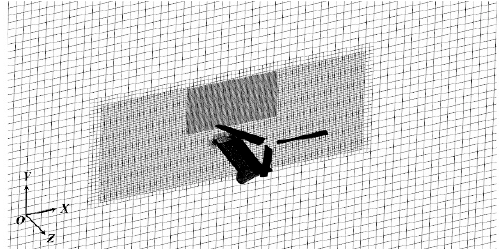
Figure 2. Chimera grid for discretization of the rotor–wing flow field.